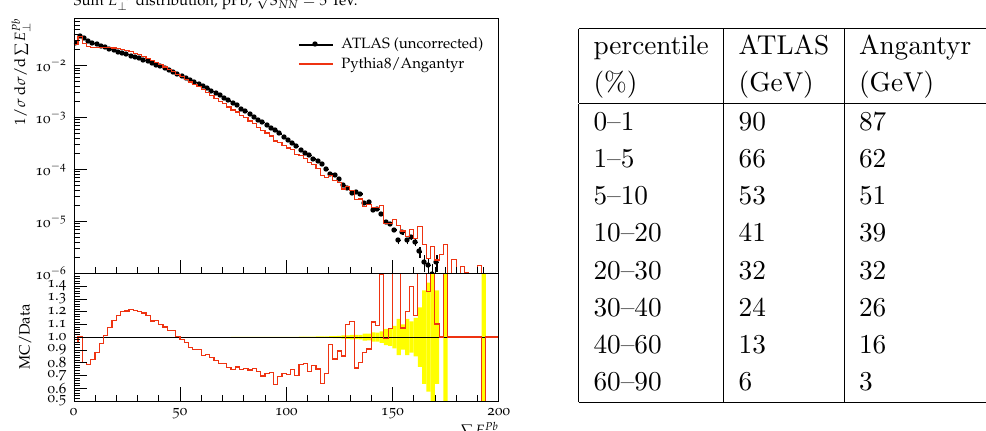
Figure 11 . The summed transverse energy in the lead direction ( collisions at p s =5 TeV. Data from ATLAS [26] is compared to results from Angantyr. The table NN shows the resulting bin edges when dividing up in percentiles for the experimental and generated data